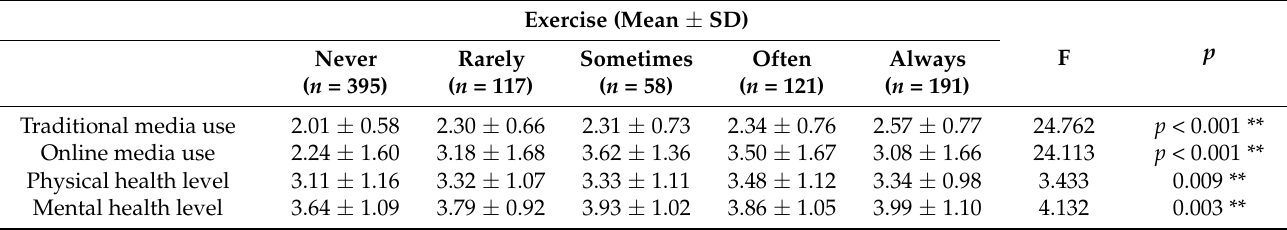
Table 3. Results of variance analysis.